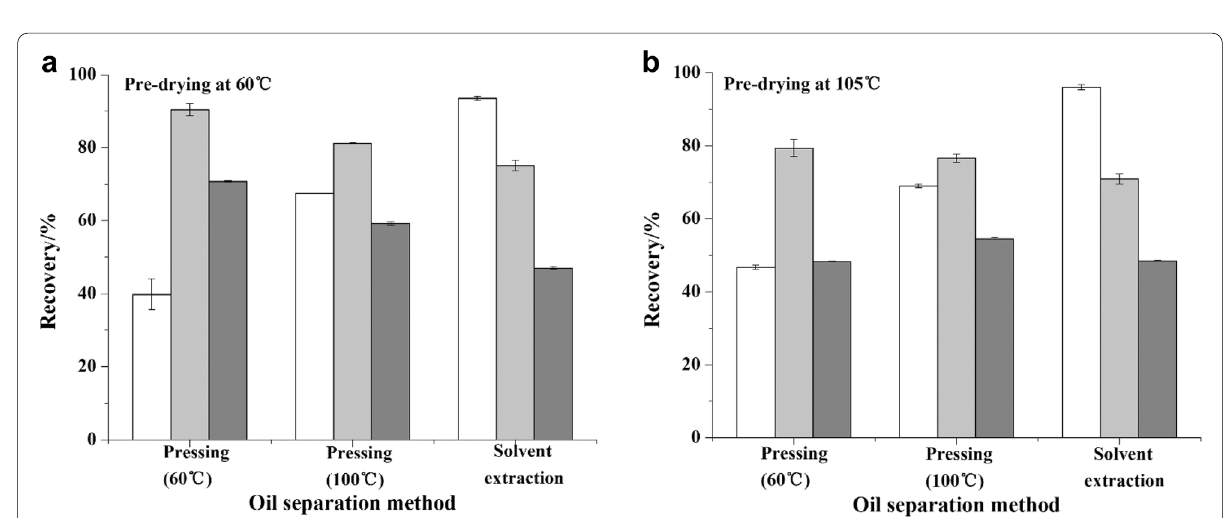
Fig. 3 Oil recovery ( ) and protein recovery from water–alkaline–alkaline treatment ( ) and from enzymatic treatment (